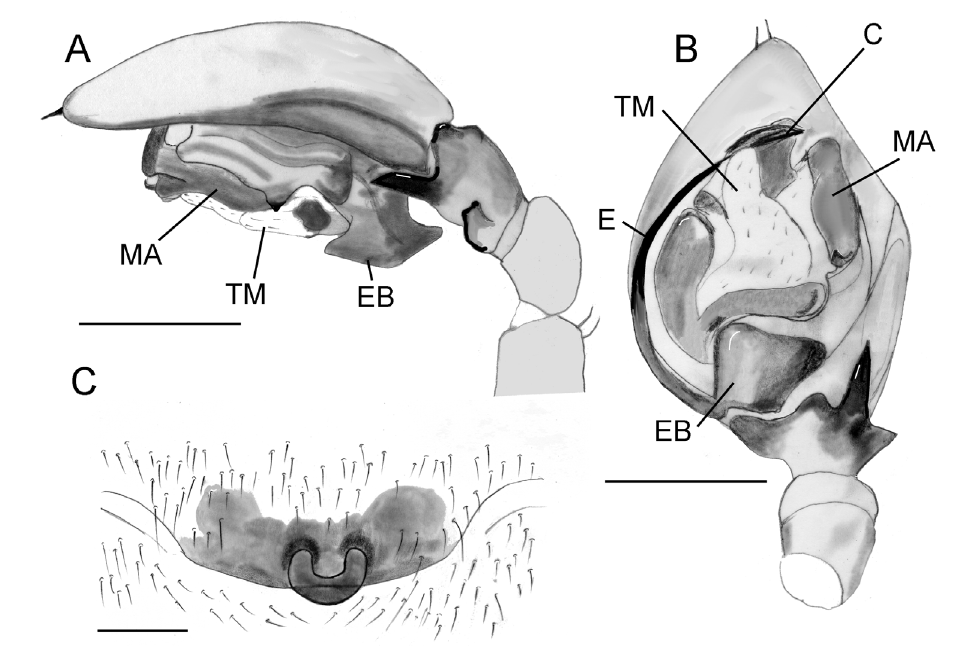
Fig. 10. Cambonilla symphonia Jocqué & Henrard gen. et sp. nov. A–B . Male holotype. C . Female paratype (RBINS IG 33.889/008). A . Male palp, retrolateral view. B . As preceding, ventral view. C . Epigyne, ventral view. Abbreviations: C = conductor; E = embolus; EB = embolus base; MA = median apophysis; TM = tegular membranous area. Scale bars: A–B = 0.5 mm; C = 1 mm; D–F = 0.2